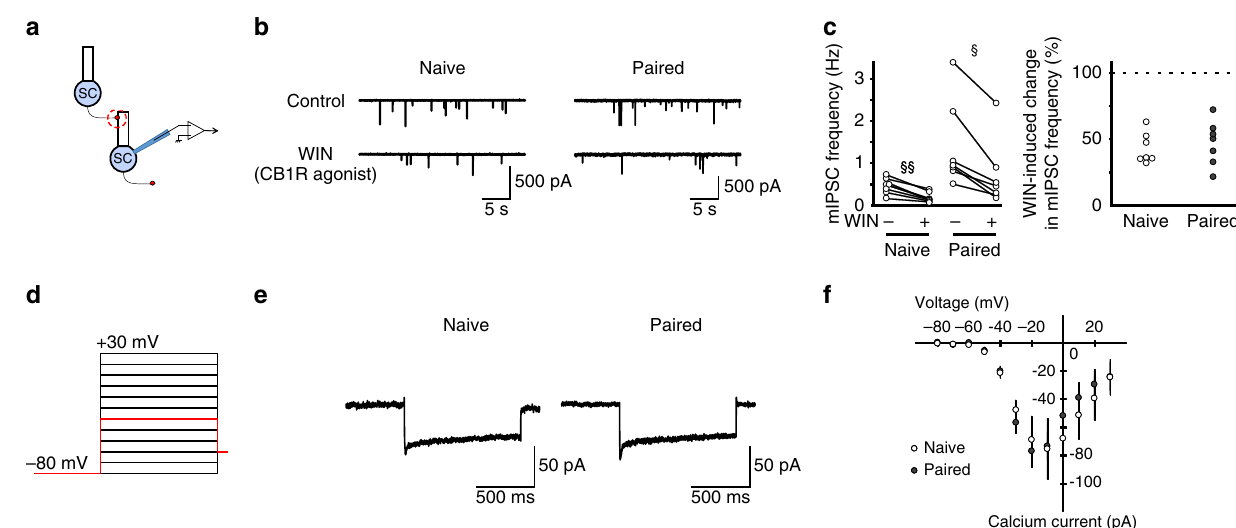
Fig. 3 Fear conditioning does not alter CB1R signaling or calcium entry that evokes eCB release. a – c CB 1 receptor signaling is not affected by fear conditioning. a Schematic of the experimental procedure. b Example traces of mIPSCs from stellate cells before and during application of CB1R agonist WIN 55212-2 . c WIN 55212-2 reduces mIPSC frequency in both naïve ( n = 7 cells) and conditioned mice ( n = 7 cells). d , e Fear conditioning did not change voltage-gated calcium currents in cerebellar stellate cells. d Voltage-clamp protocol used to evoke calcium currents. e Example traces of calcium currents in response to membrane depolarization to − 30 mV (shown in red in d ). For representation purpose, artifacts have been fi ltered out. f Group data showing the current – voltage relationship of calcium currents recorded in stellate cells from naïve (open circles, n = 5 cells) and paired ( fi lled circles, n = 7 cells) animals. Effects of WIN on mIPSC frequency in naïve were compared with paired group using a two-way RM ANOVA followed by Tukey ’ s post hoc test (§, P < 0.05; §§, P < 0.01). Data are presented as mean values ± SEM. Statistical analysis and P and F values can be found in Supplementary Table 4 and original data in the Source Data fi